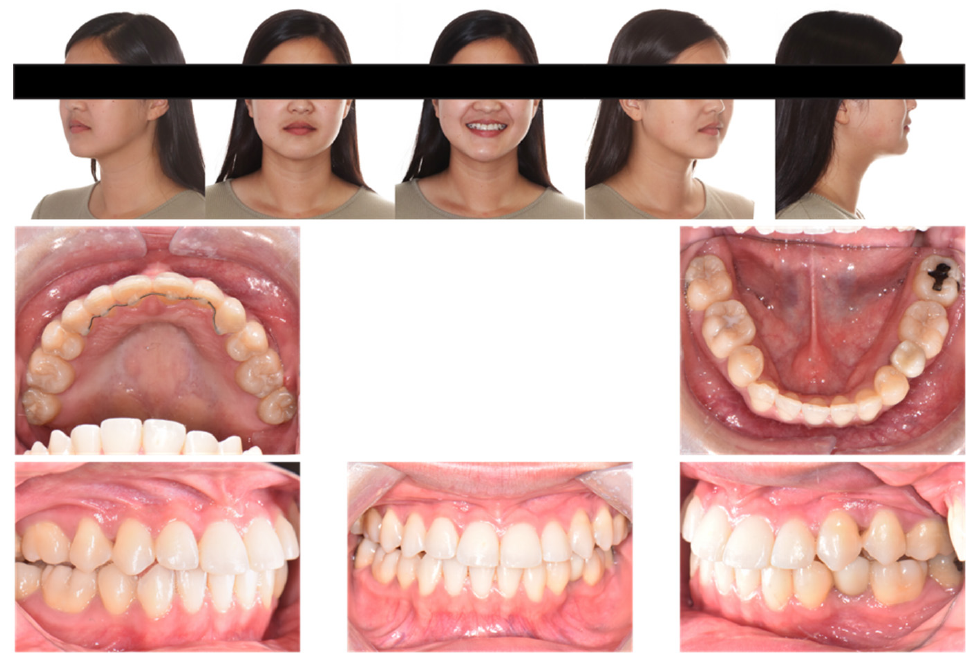
Figure 8. Thirty-fifth-month progress facial and intraoral photographs.